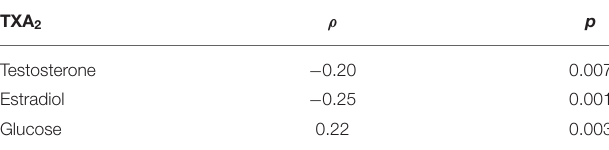
TABLE 2 | Correlation between TXA 2 and testosterone, estradiol, or